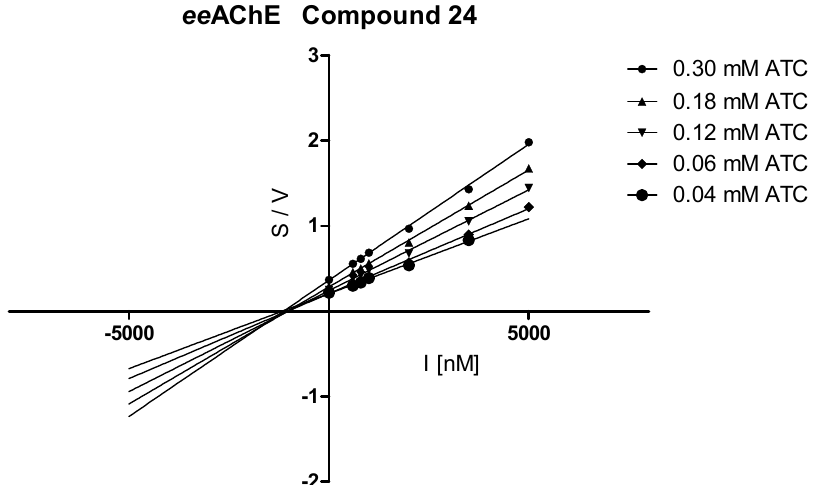
Figure 3. Cornish-Bowden plot illustrating a noncompetitive type of ee AChE inhibition by compound 24 . S = acetylthiocholine; V = initial velocity rate; I = inhibitor concentration.